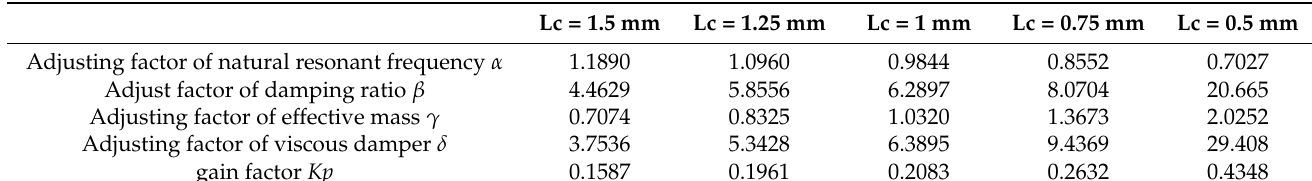
Table 5. Results of adjusting factors of natural resonant frequency, damping ratio, effective mass, and viscous damper for varied volumes of Helmholtz resonant cavity.